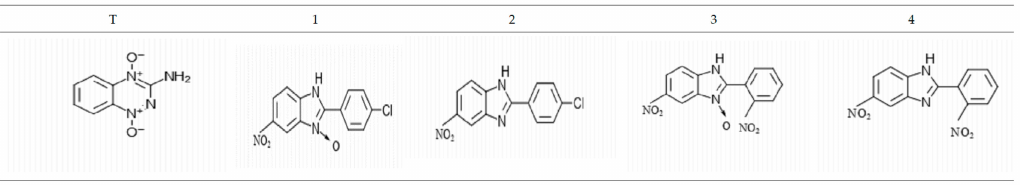
Figure 1. Structure of tested compounds 1–4 and tirapazamine